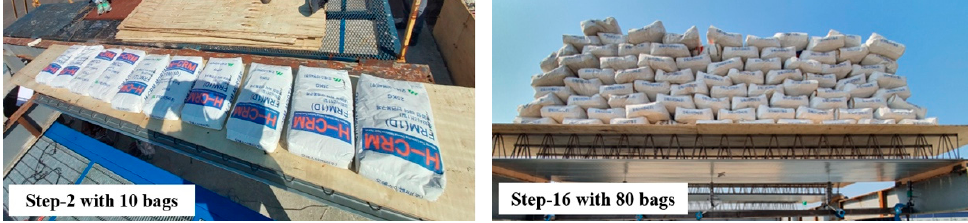
Figure 4. Photos at Step-2 with 10 load bags and Step-16 with 80 load bags. Table 3. Loading plan.